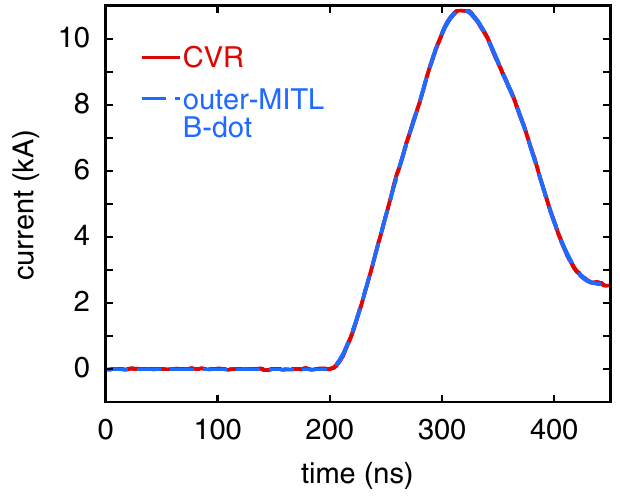
FIG. 5. (Color) Result of the calibration of an outer-MITL B -dot current monitor. The reference current is that measured by a current-viewing resistor (CVR). The normalized standard devia- tion of the pointwise difference [Eq. (12)] between the two current-pulse shapes is less than 1%.